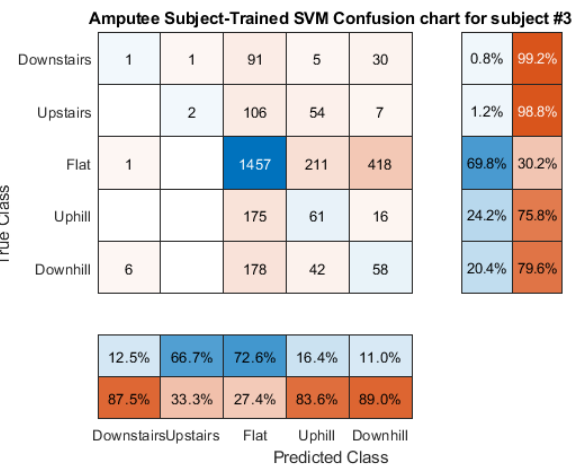
Figure A13. Support Vector Machine Confusion Chart for ILLA participant A3 as trained by all other ILLA participants.